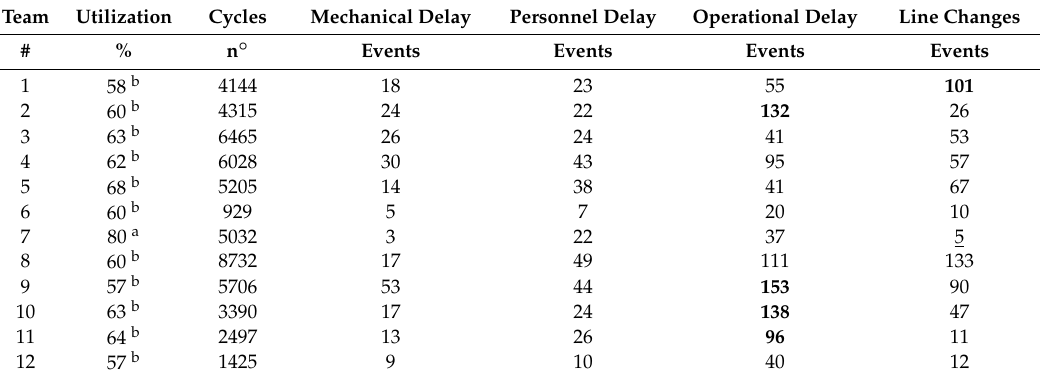
Table 3. Machine utilization and distribution of the number of delay events by grapple yarder team. Team